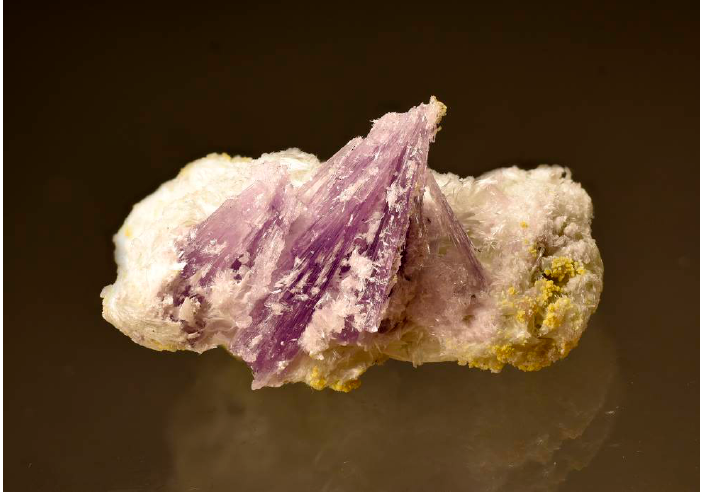
Figure 12. Goldichite, purple prismatic crystals, up to 2 cm in length, associated with fibrous halotrichite, from the Monte Arsiccio mine.